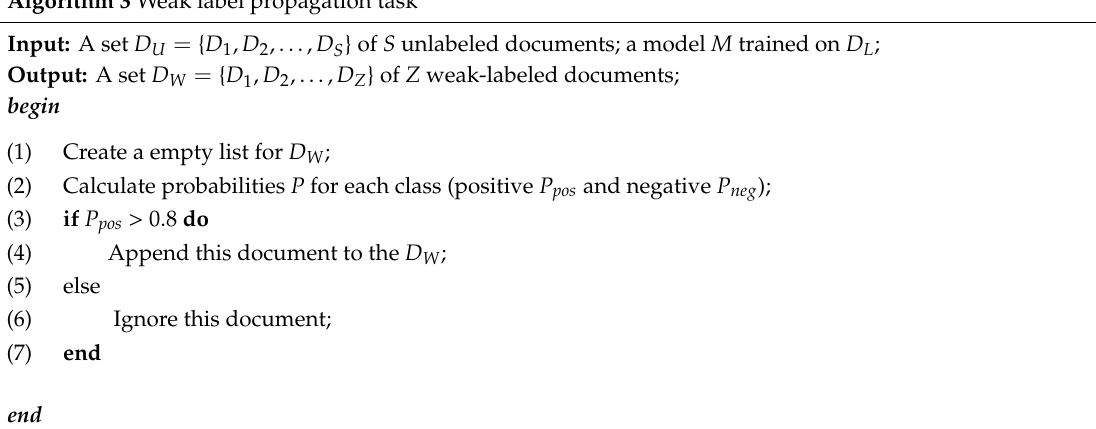
Algorithm 3 Weak label propagation task